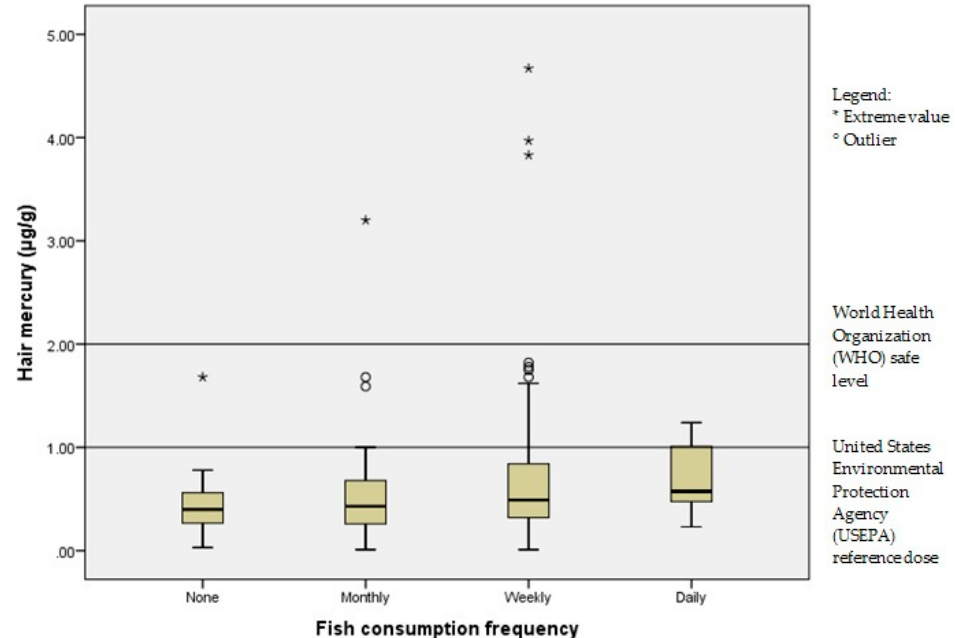
Figure 2. Distribution of hair mercury according to fish consumption frequency.